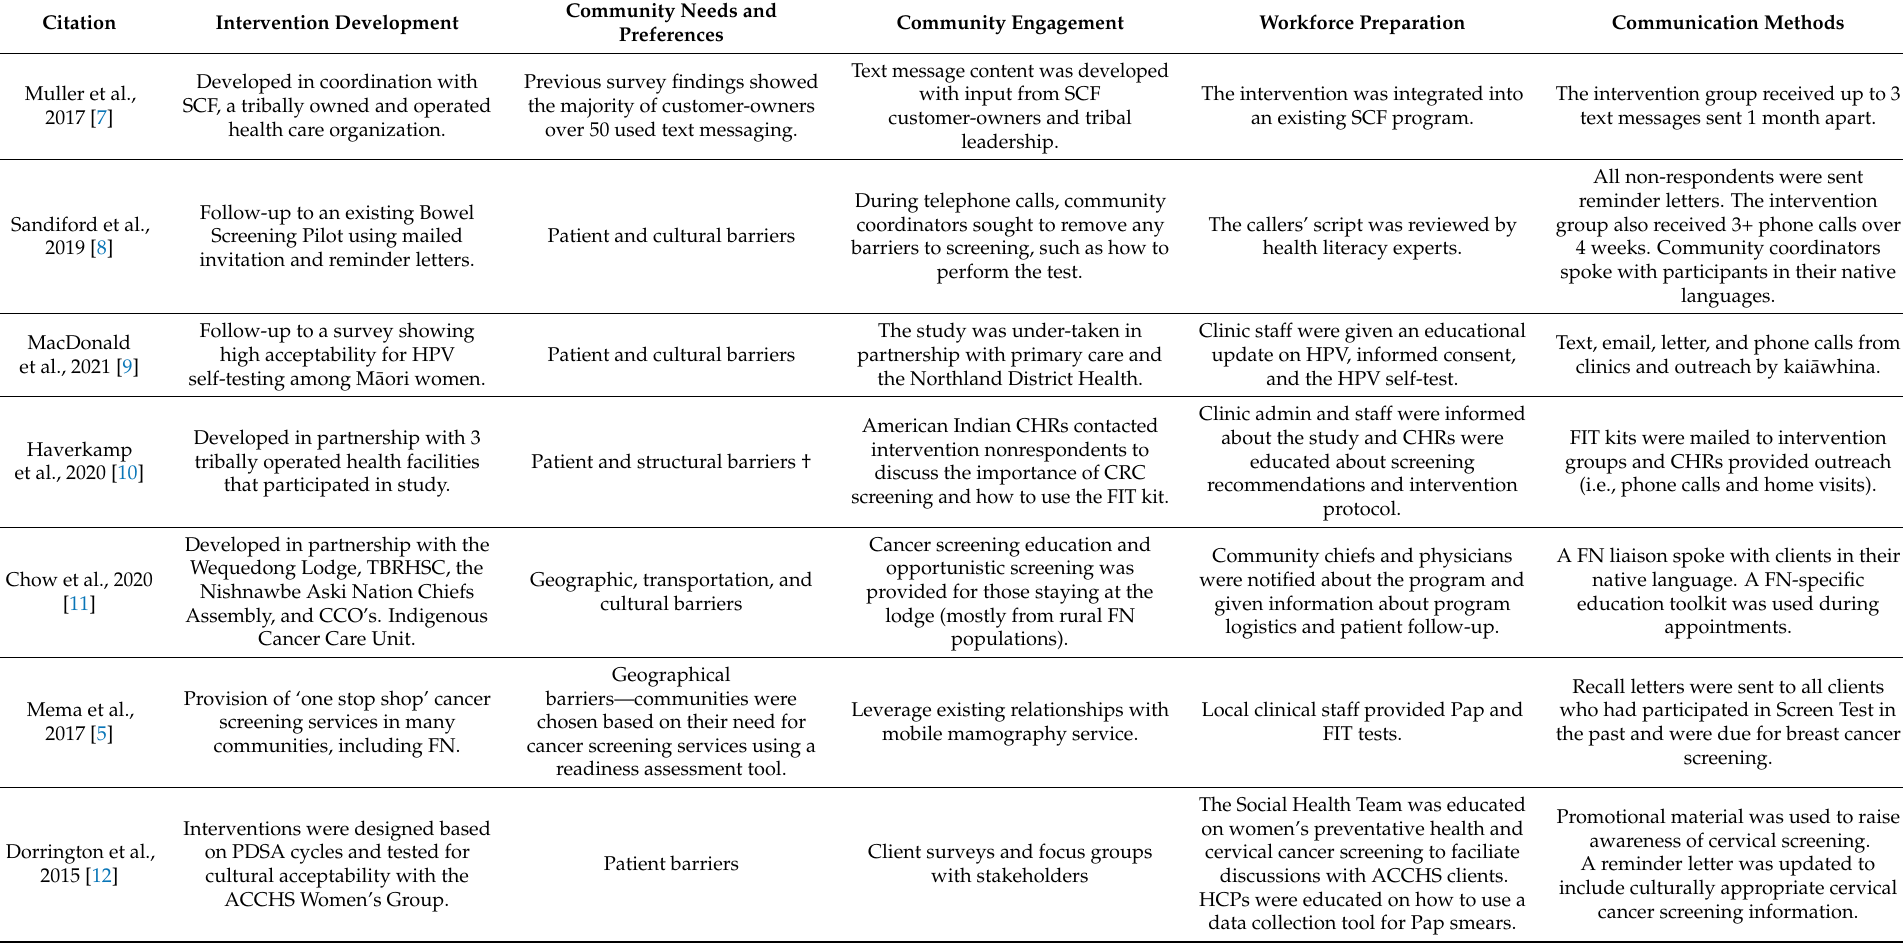
Table 5. Descriptive Table of Key Characteristics of the